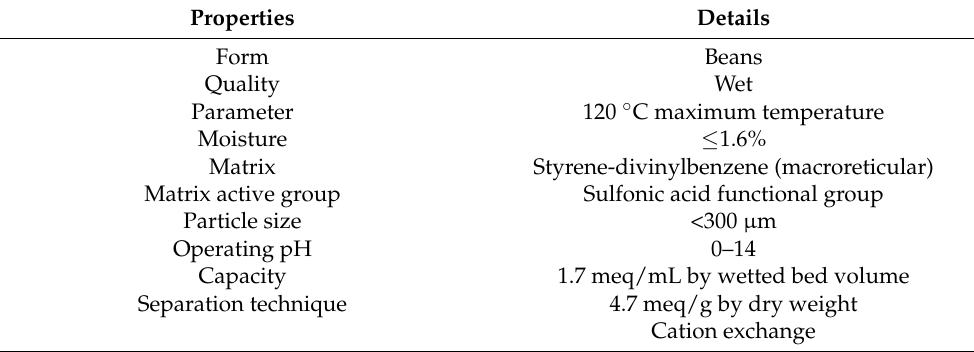
Table 6. The properties of Amberlyst